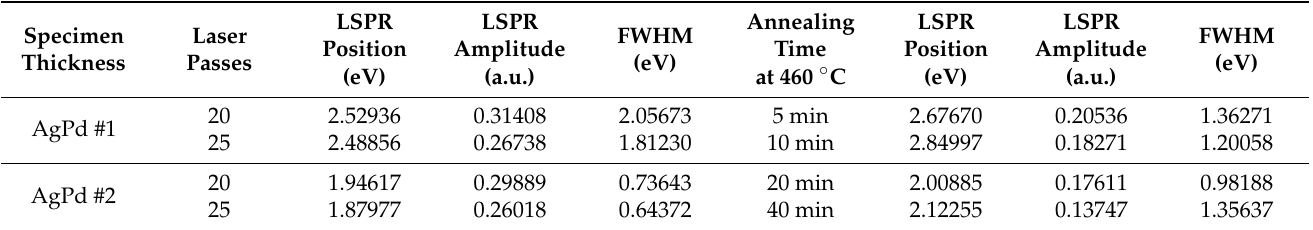
Table 4. LSPR characteristics of AgPd multilayers as a function of the laser passes and annealing time at 460 °C .